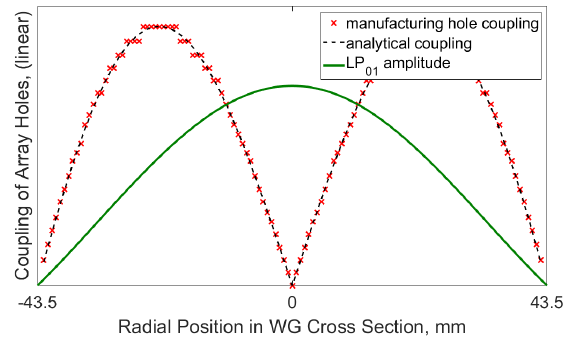
Figure 12. Coupling structure of main mode coupler.